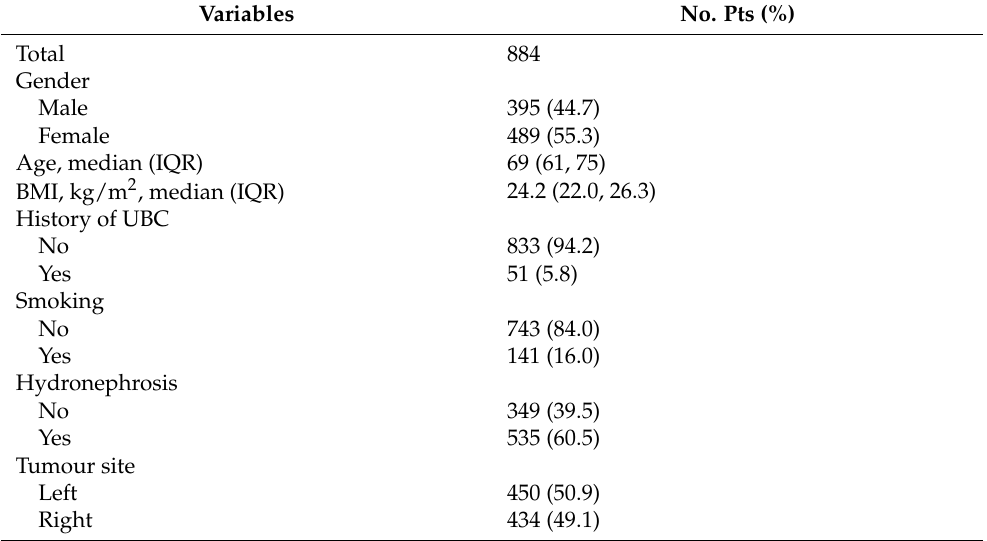
Table 1. Clinical and pathological characteristics in patients with UTUC. IQR, interquartile range; UBC, urothelial bladder carcinoma; PUNLMP, papillary urothelial neoplasm of low malignant